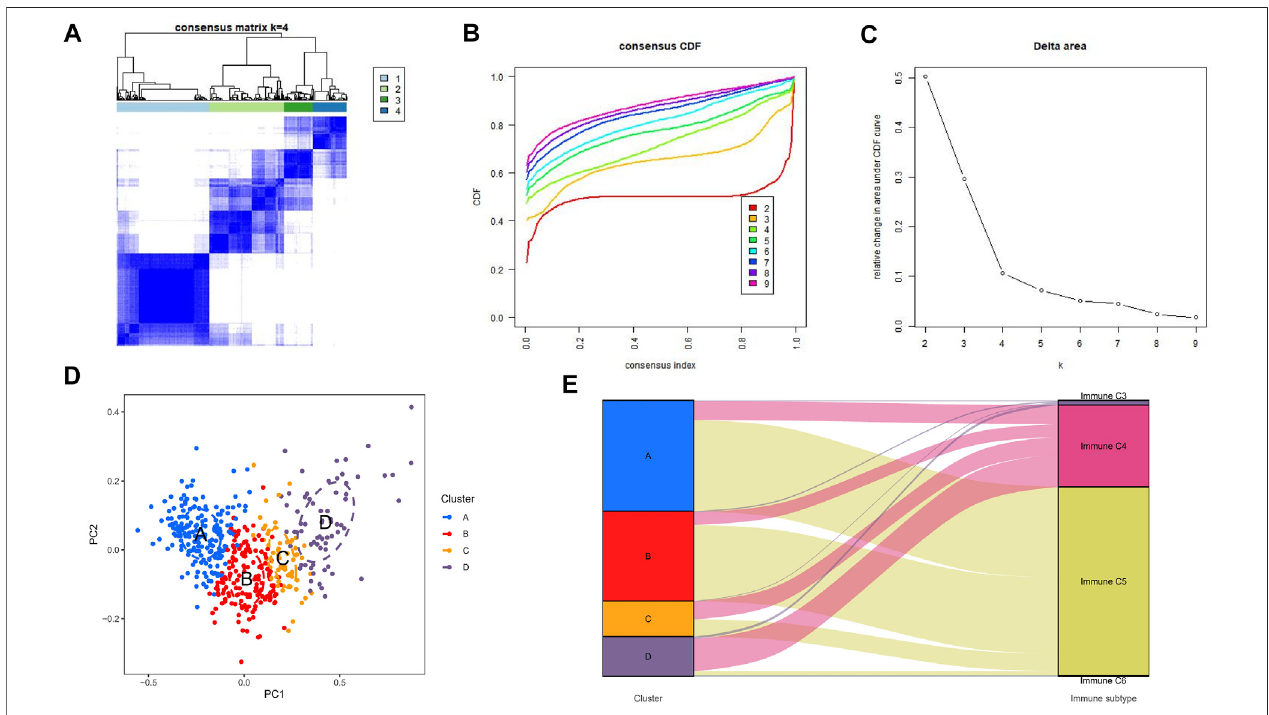
FIGURE 1 | Consensus clustering results in TCGA-LGG cohorts. (A) Consensus clustering matrix of k = 4 as the optimal cluster number. (B) CDF curves of the consensus score from k = 2 – 9. (C) Delta area under the CDF curve. (D) Principal component analysis for the ssGSEA scores of four clusters. Each subgroup was distinguished by different colors. (E) Sankey diagram to visualize the relationships between our four clusters and the six identi fi ed immune function